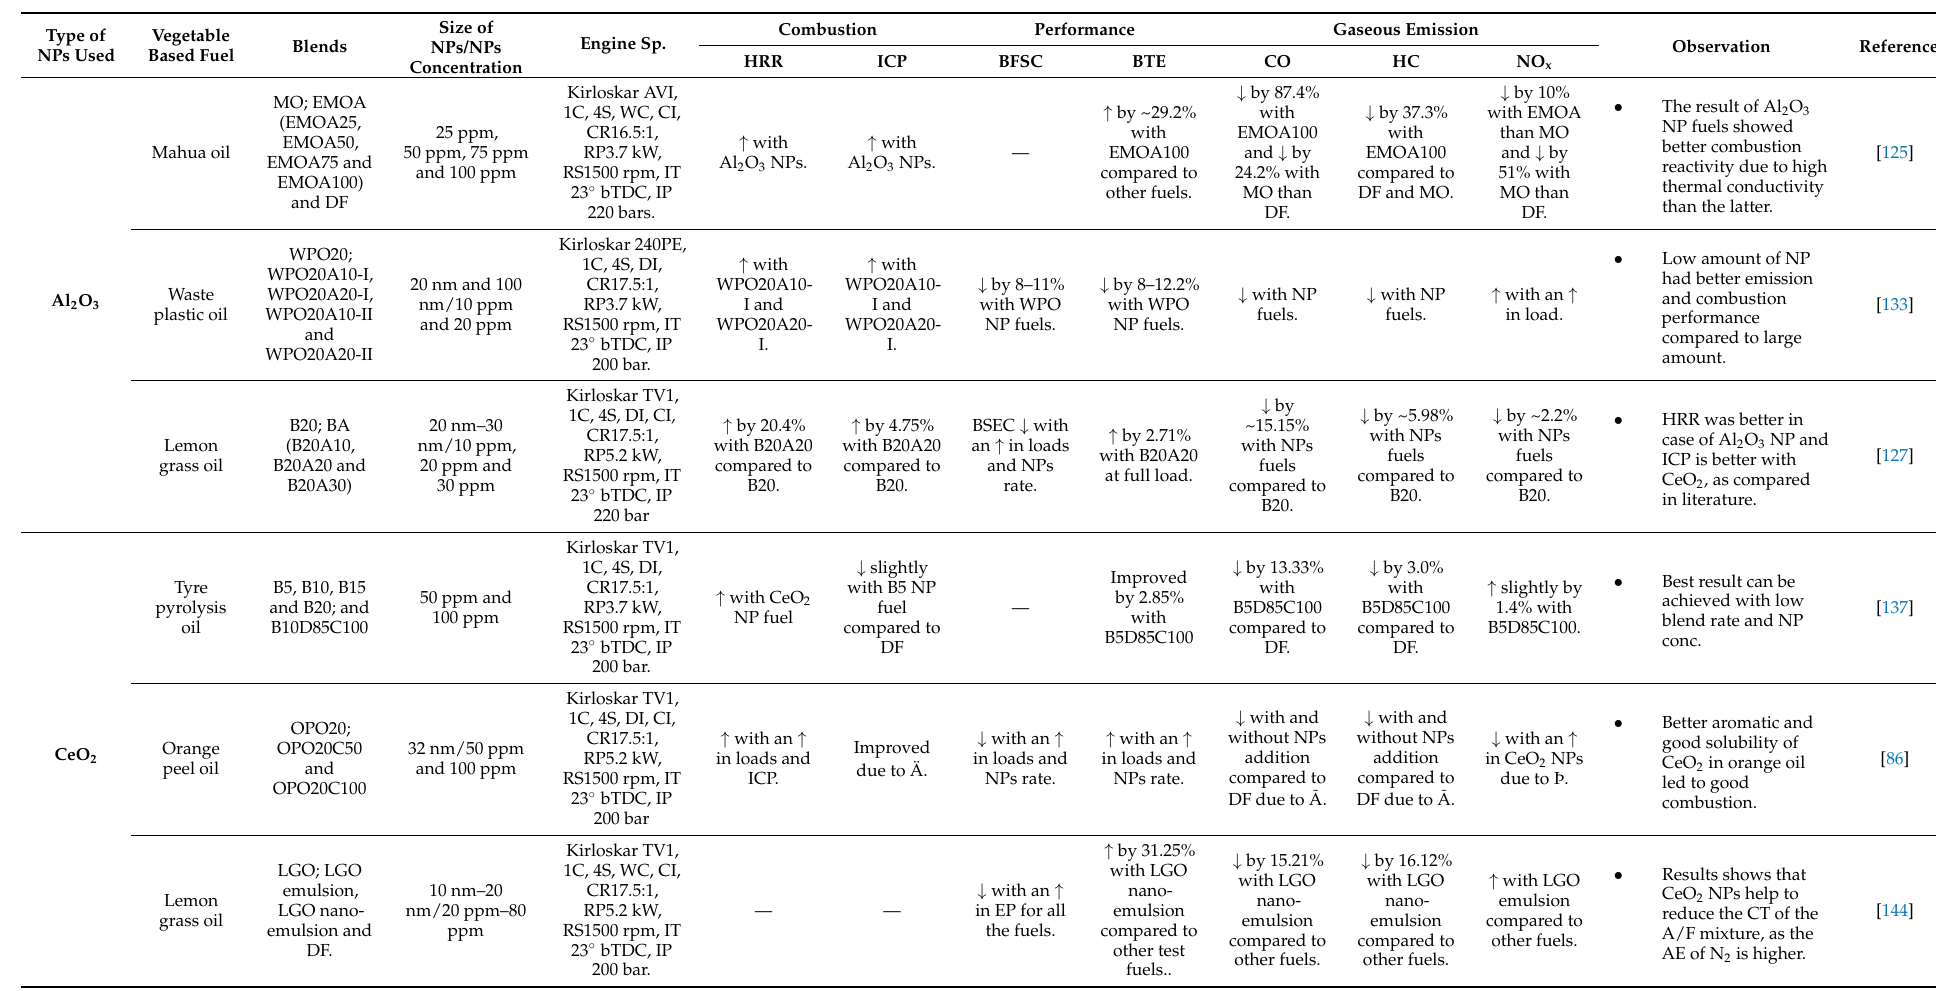
Combustion Performance Gaseous Emission